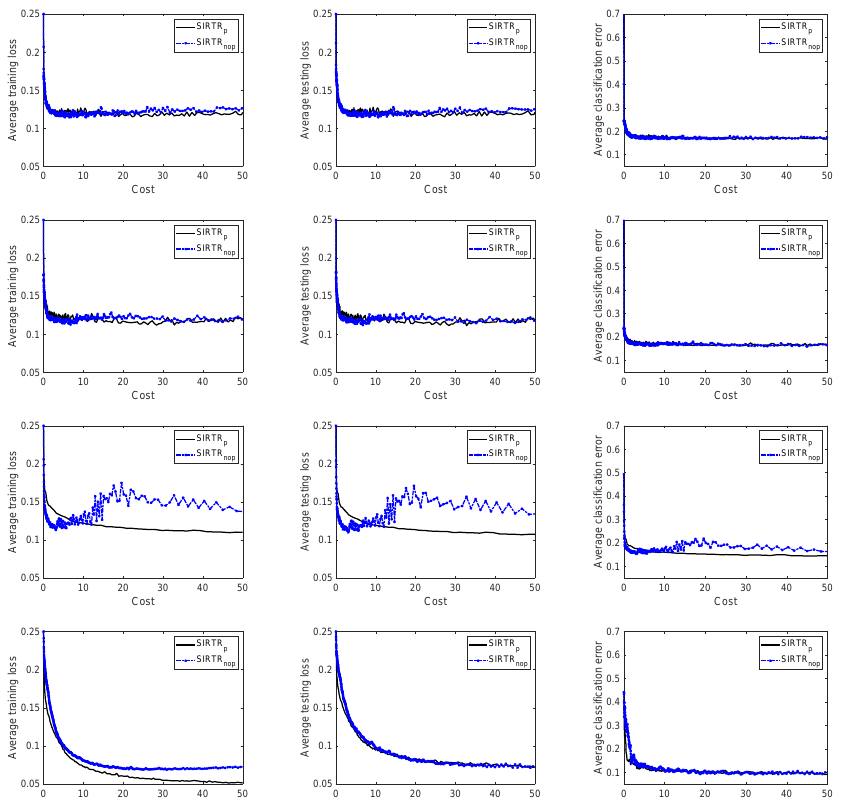
Figure 1. From top to bottom row: data sets a8a , a9a , mnist , phishing . From left to right: average training loss, testing loss, and classification error versus average computational cost.